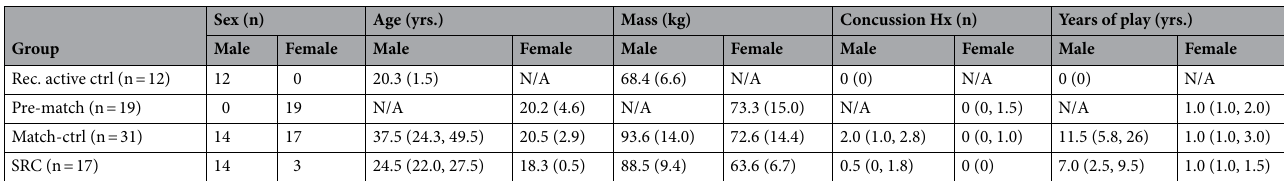
Table 1. Descriptive statistics for each group with separated male and female data. Subjects were all Caucasian. All data reported as mean (SD) except when the SD is greater than 1/3 of the mean. In these cases data are reported as median (Q1, Q3). Rec. Active Ctrl = Recreationally active control group, Match- Ctrl = Match-Control group, SRC = Sport-related Concussion group, Hx = history, SD = standard deviation, Q1 = 1st quartile, Q3 = 3rd